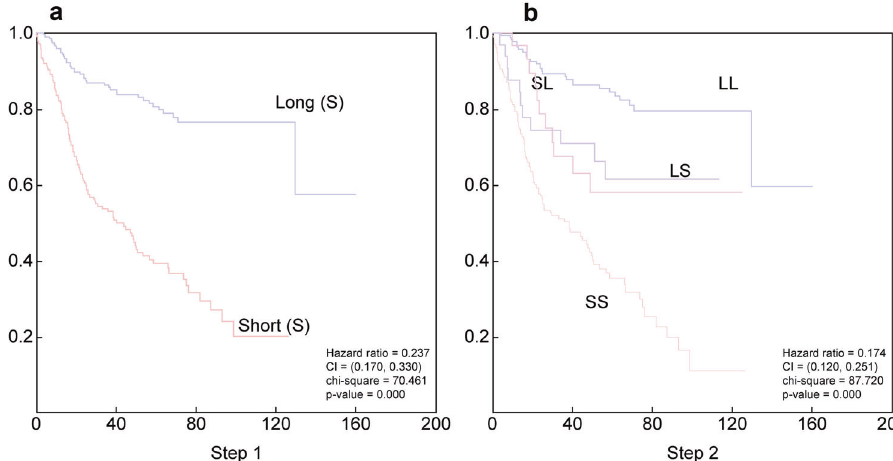
Fig. 1 Prediction of patient survival using supervised machine learning without biomarkers (379 cases). a Survival when divided into two group. b Survival when each of the previous group is further divided into two groups. CI con fi dence